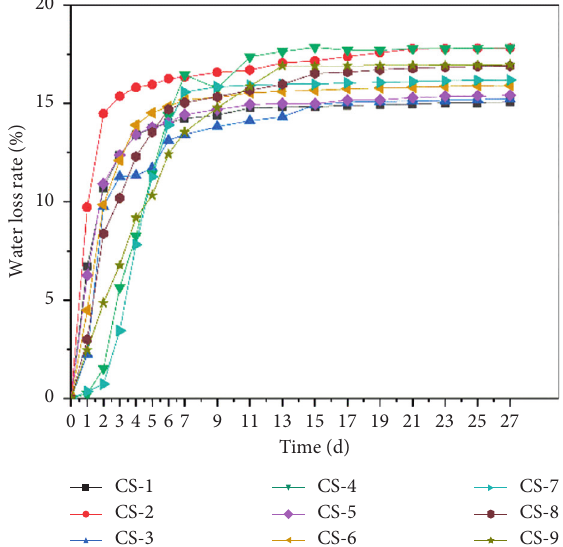
Figure 5: The changes of water loss rate with time.